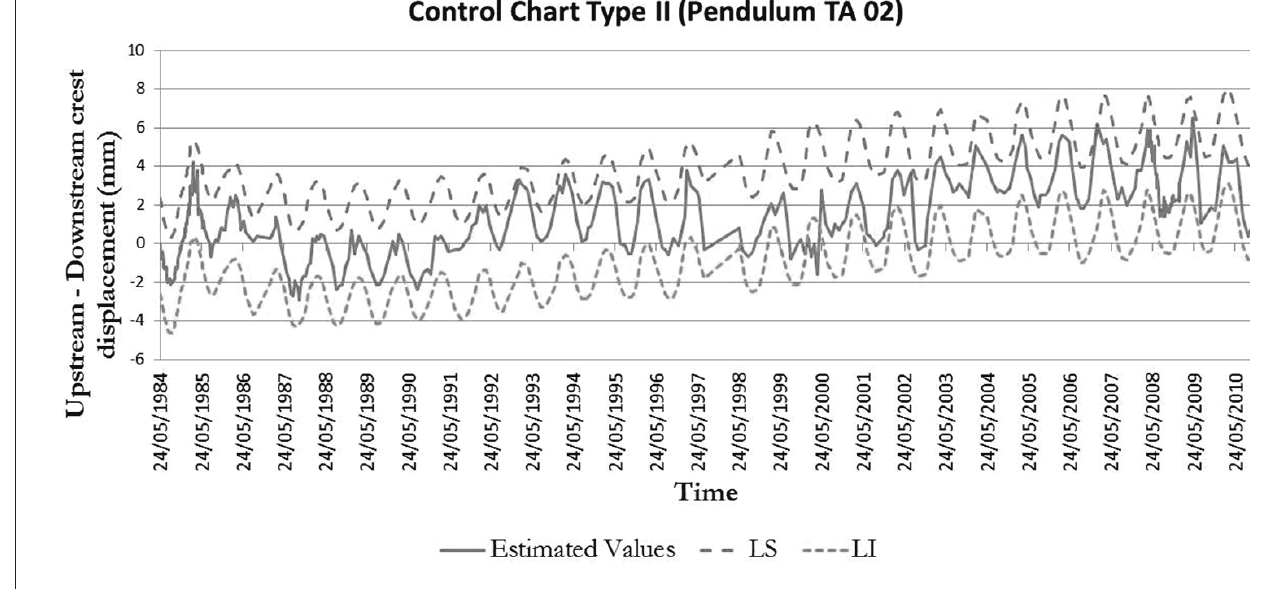
The Control Chart Type I, for residual regression, has the advan - tage of more clearly showing the periods in which major differ - ences occur between instrument readings and the predicted val - ues. On the other hand, Control Chart Type II has the advantage